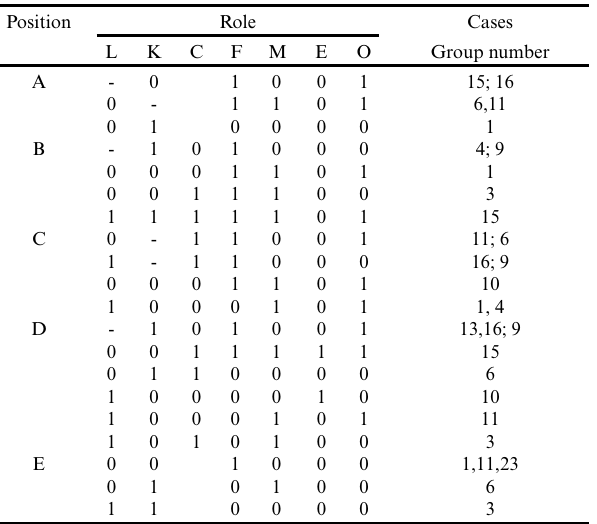
Table 4 . csQCA results of each position independently (truth table is shown in Appendix 3).